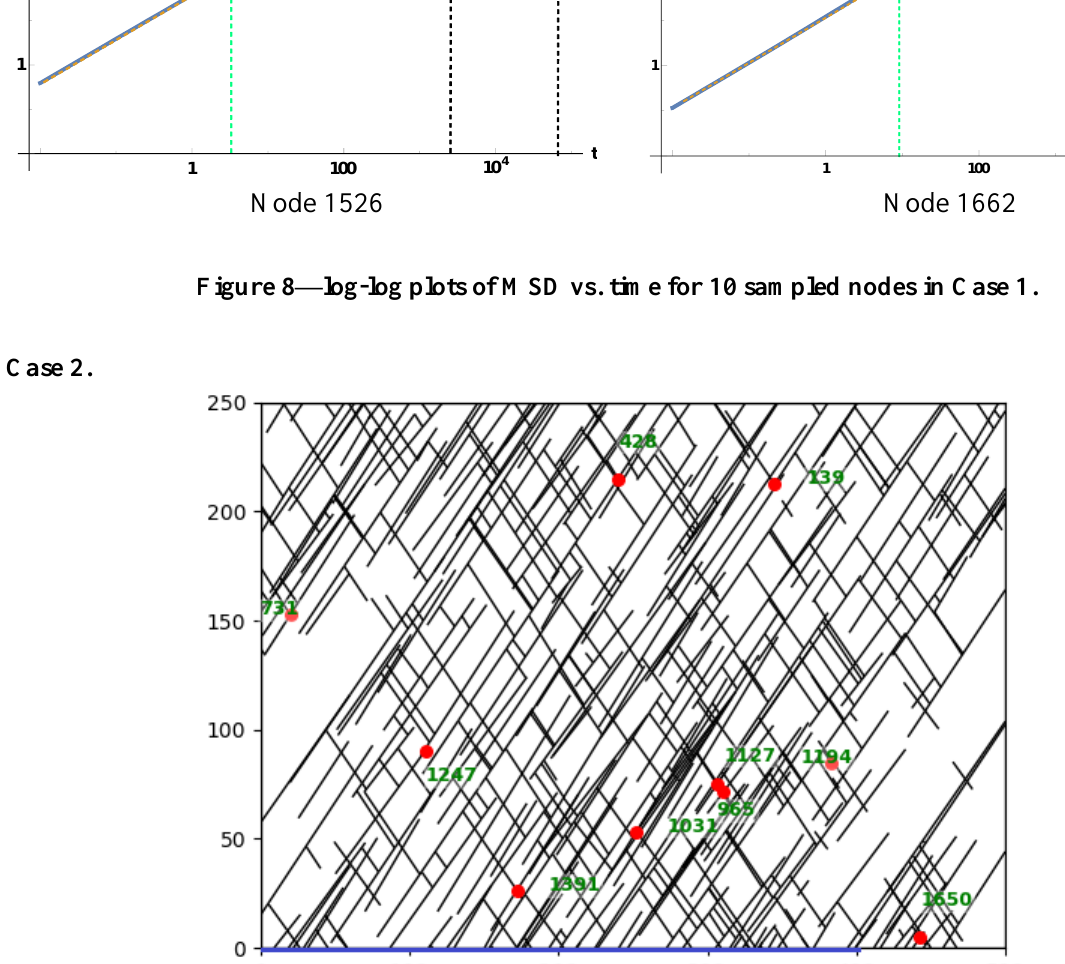
Figure 9—Map view plot of the fracture network and 10 sampled nodes in Case 2.